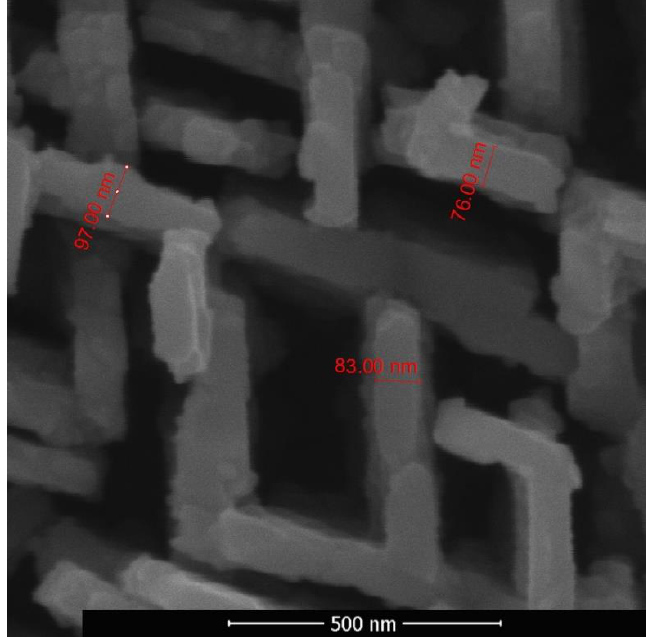
Figure 10. Array of two-dimensional nano-objects with characteristic thicknesses of 70–100 nm. X-ray spectral analysis was performed using an REM-100U scanning electron